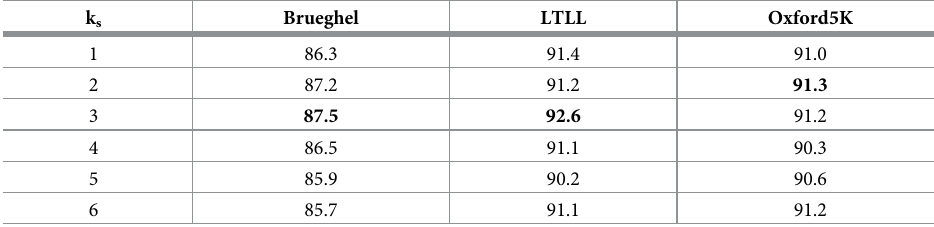
Table 2. Effect of the number of style templates.